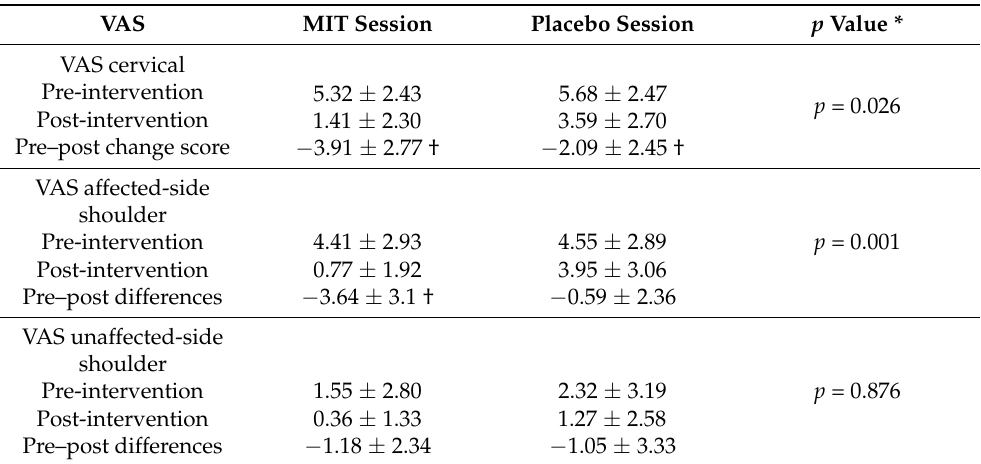
Table 2. Pre-intervention, post-intervention, and change scores for VAS ( n = 22). VAS MIT Session Placebo Session p Value * VAS